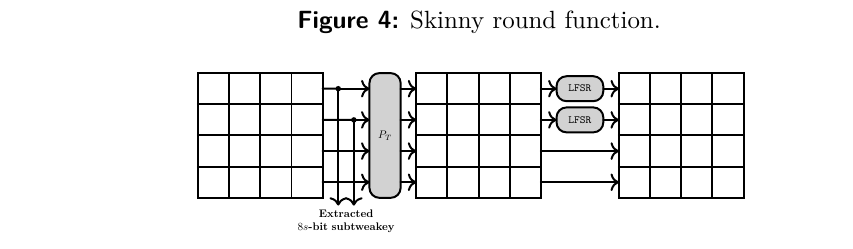
Figure 5: Skinny tweakey